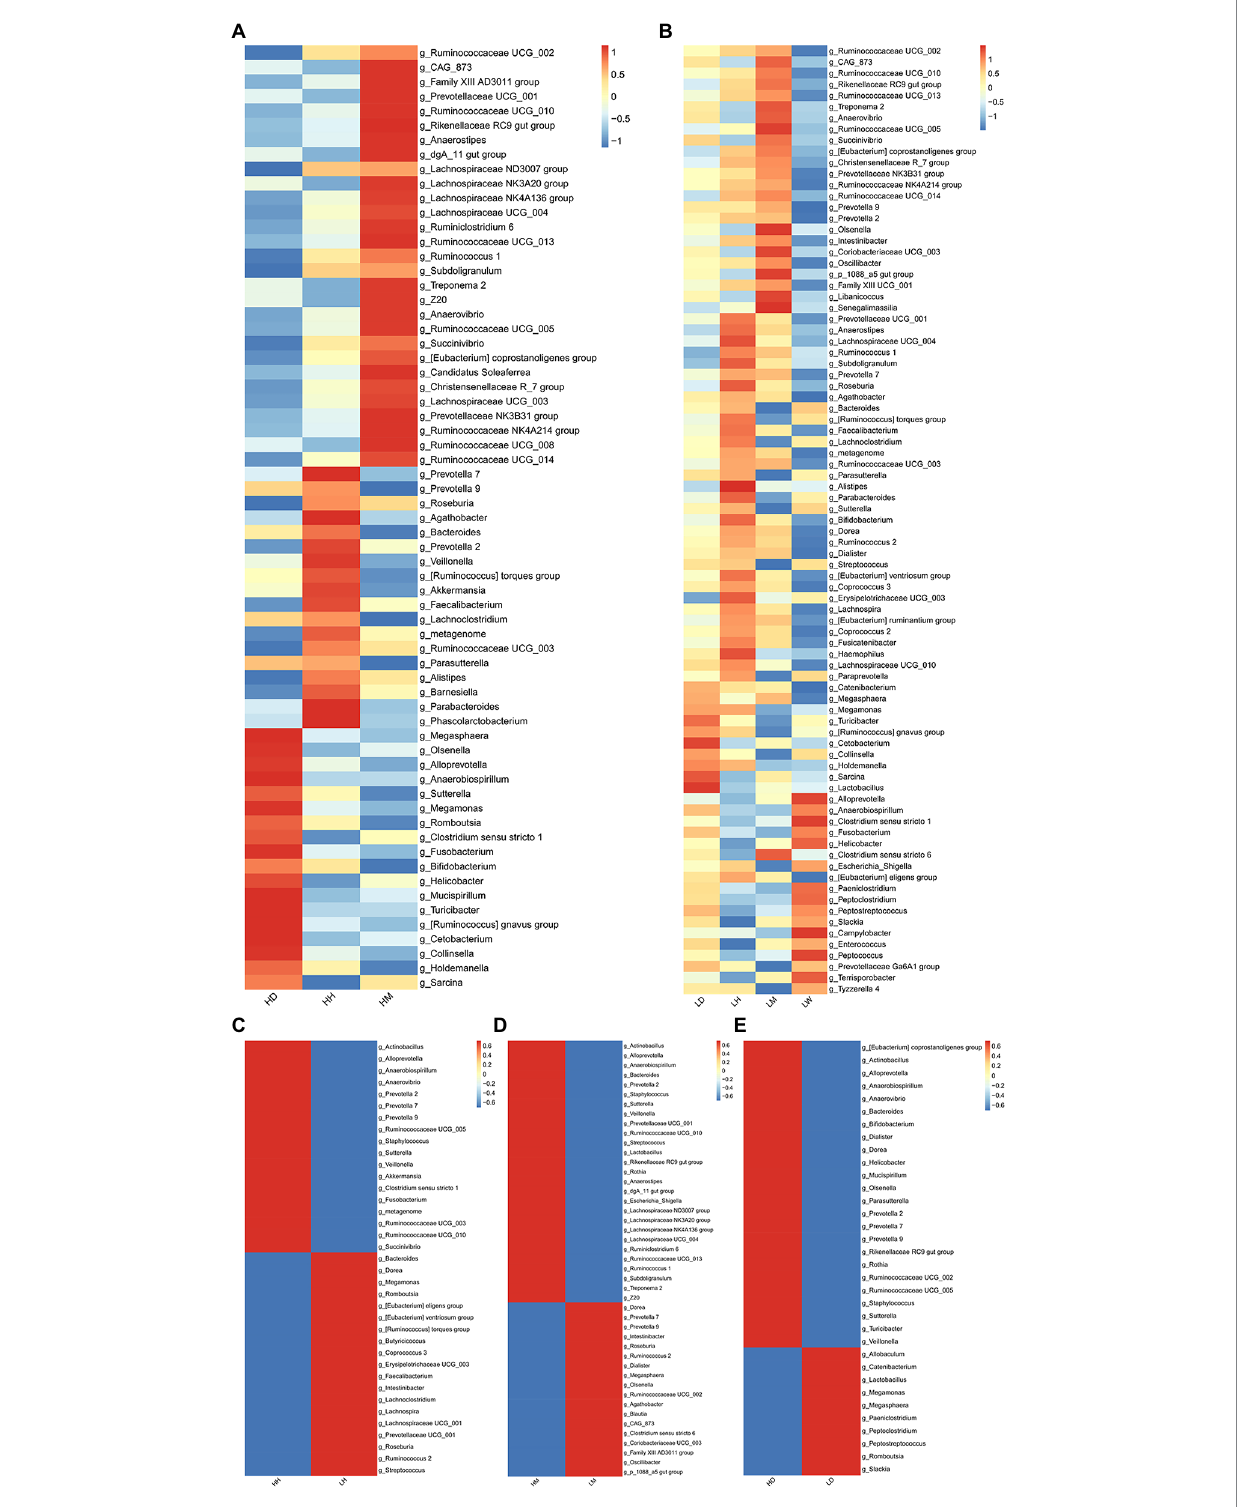
FIGURE 6 Heatmap showing the genus level LEFSe test (LDA > 2, p < 0.05) of gut microbiota among different species in the same altitude environments and between different altitude environments in the same species. (A) Comparison among three species at high altitude, (B) Comparison among three species at low altitude, (C) Comparison between high altitude and low altitude of humans, (D) Comparison between high altitude and low altitude of macaques, (E) Comparison between high altitude and low altitude of dogs. HH stands for high altitude humans, HD stands for high altitude dogs, HM stands for high altitude wild macaques, LH stands for low altitude humans, LD stands for low altitude dogs, LM stands for low altitude wild macaques, LW stands for low